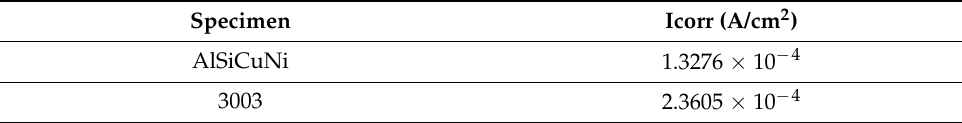
Figure 12. Polarization potential test of filler metal and base metal. Table 6. Polarization curve fitting results of filler metal and base metal.